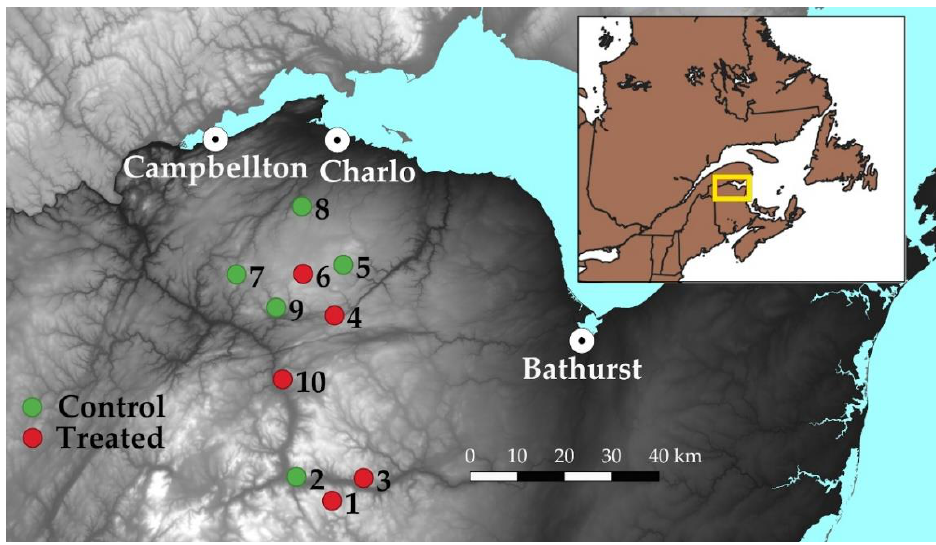
Figure 1. Location of treatment (red) and control (green) sites 1-10, used in the 2021 large-scale mating disruption field trial with CONFOUND SBW . Darker region: north-eastern New Brunswick, Canada; Paler region: south of the Gaspe Peninsula, Quebec, Canada.